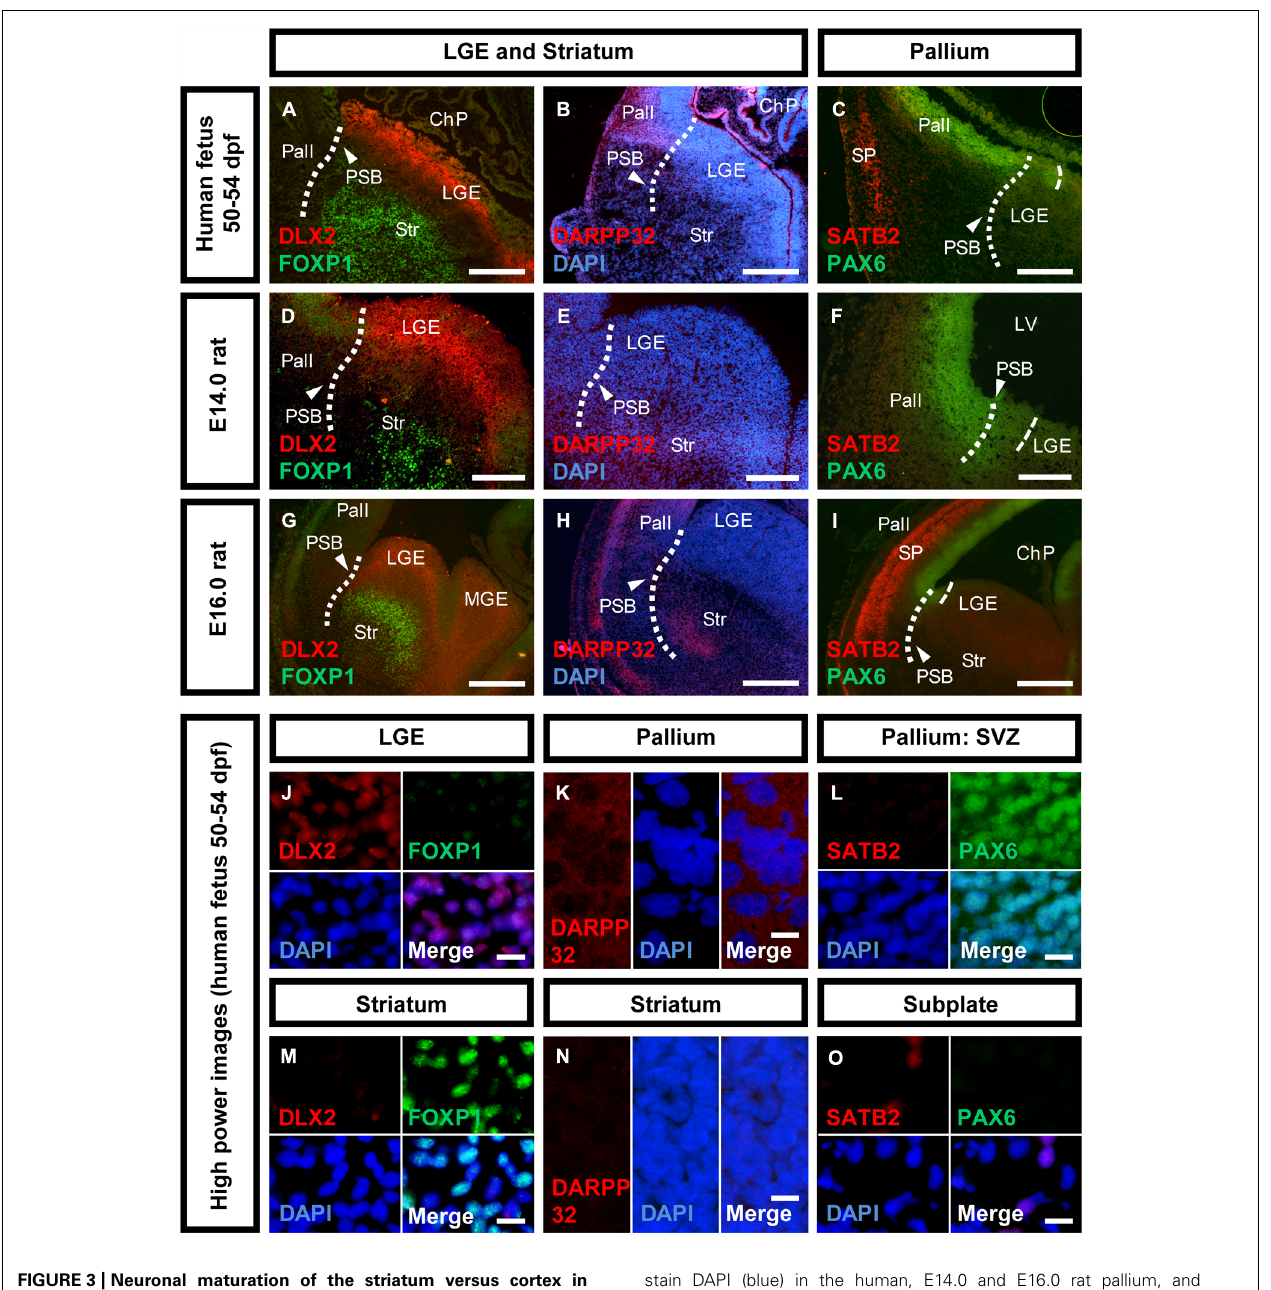
FIGURE 3 | Neuronal maturation of the striatum versus cortex in human and rat. Photomicrographs of coronal sections of the human and rat telencephalon. (A,D,G,J,M) Expression of DLX2 (red) and FOXP1 (green) in the human, E14.0 and E16.0 rat LGE and striatum. (B,E,H,K,N) Expression of DARPP32 (red) and the nuclear counter